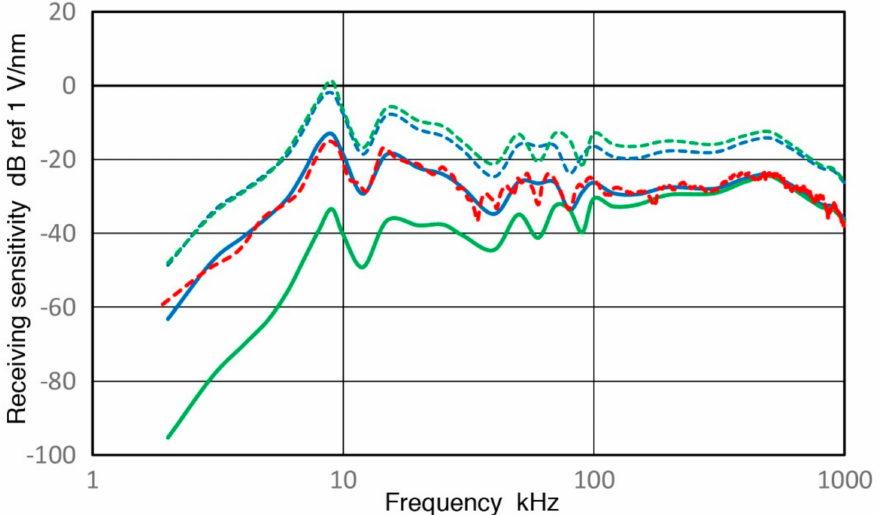
Figure 13. Receiving displacement sensitivity spectra (Z in = 1 M Ω and 10 k Ω ) are shown (in blue and green) against log-frequency (in kHz) for KRN BB-PCP sensor in dB in reference to 1 V/nm. The corresponding pulse sensitivity spectrum is given in red dash curve. Calculated open-circuit sensitivity is in blue and green dot curves (using sinewave data of Z in of 1 M Ω and 10 k Ω